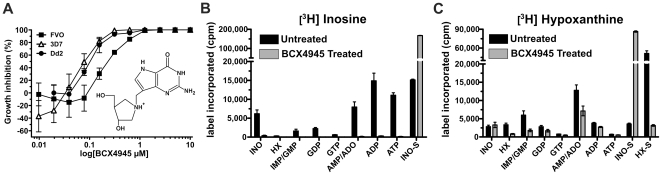
BCX4945 inhibits PNP to block inosine salvage.(A) Chemical structure and effect of BCX4945 on in vitro growth of different P. falciparum strains. Parasites were incubated in the presence of the indicated concentrations of BCX4945 for 72 h at 1% hematocrit, followed by DNA quantitation. IC50 values were calculated from fits (Origin software) to the overall response curve. The graph is constructed by individual point connections. (B, C) Counts per minute (cpm) levels of [3H]inosine and [3H]hypoxanthine metabolically incorporated into purine derivatives. P. falciparum infected-red blood cells in schizont and trophozoite stages were metabolically labeled with [3H]inosine or [3H]hypoxanthine in the absence or presence of 10 µM of BCX4945. Labeled inosine (INO-S) and hypoxanthine (HX-S) present in the supernatant. Means ± s.d. from triplicates are represented.